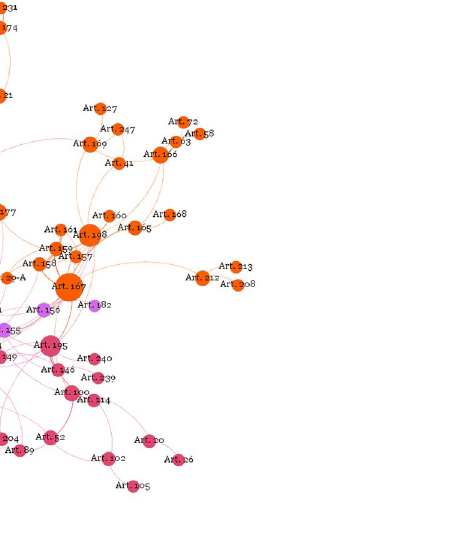
Fig 1. Network of cited articles: Communities of the